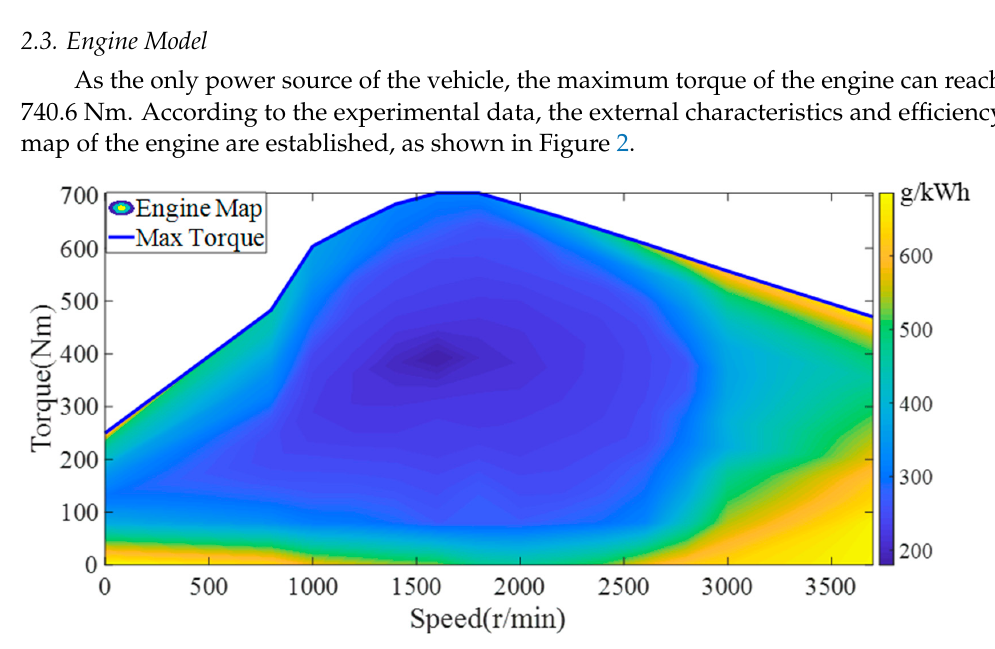
. Table 4. Brake related parameter setting. Parameter